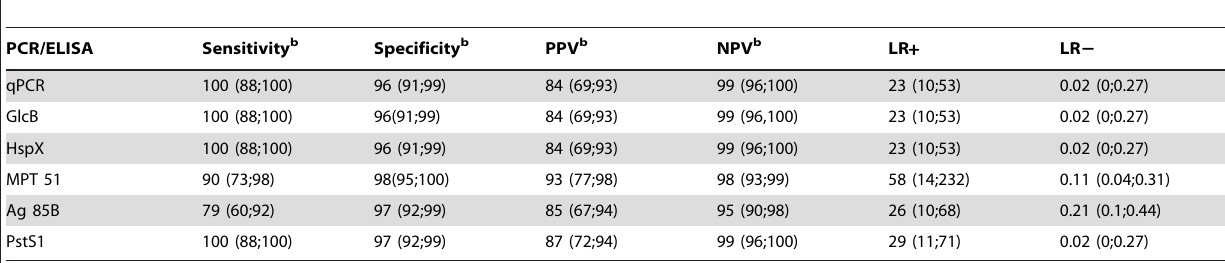
Table 1. Performance of ELISA and PCR assays in Definite TBM subjects.